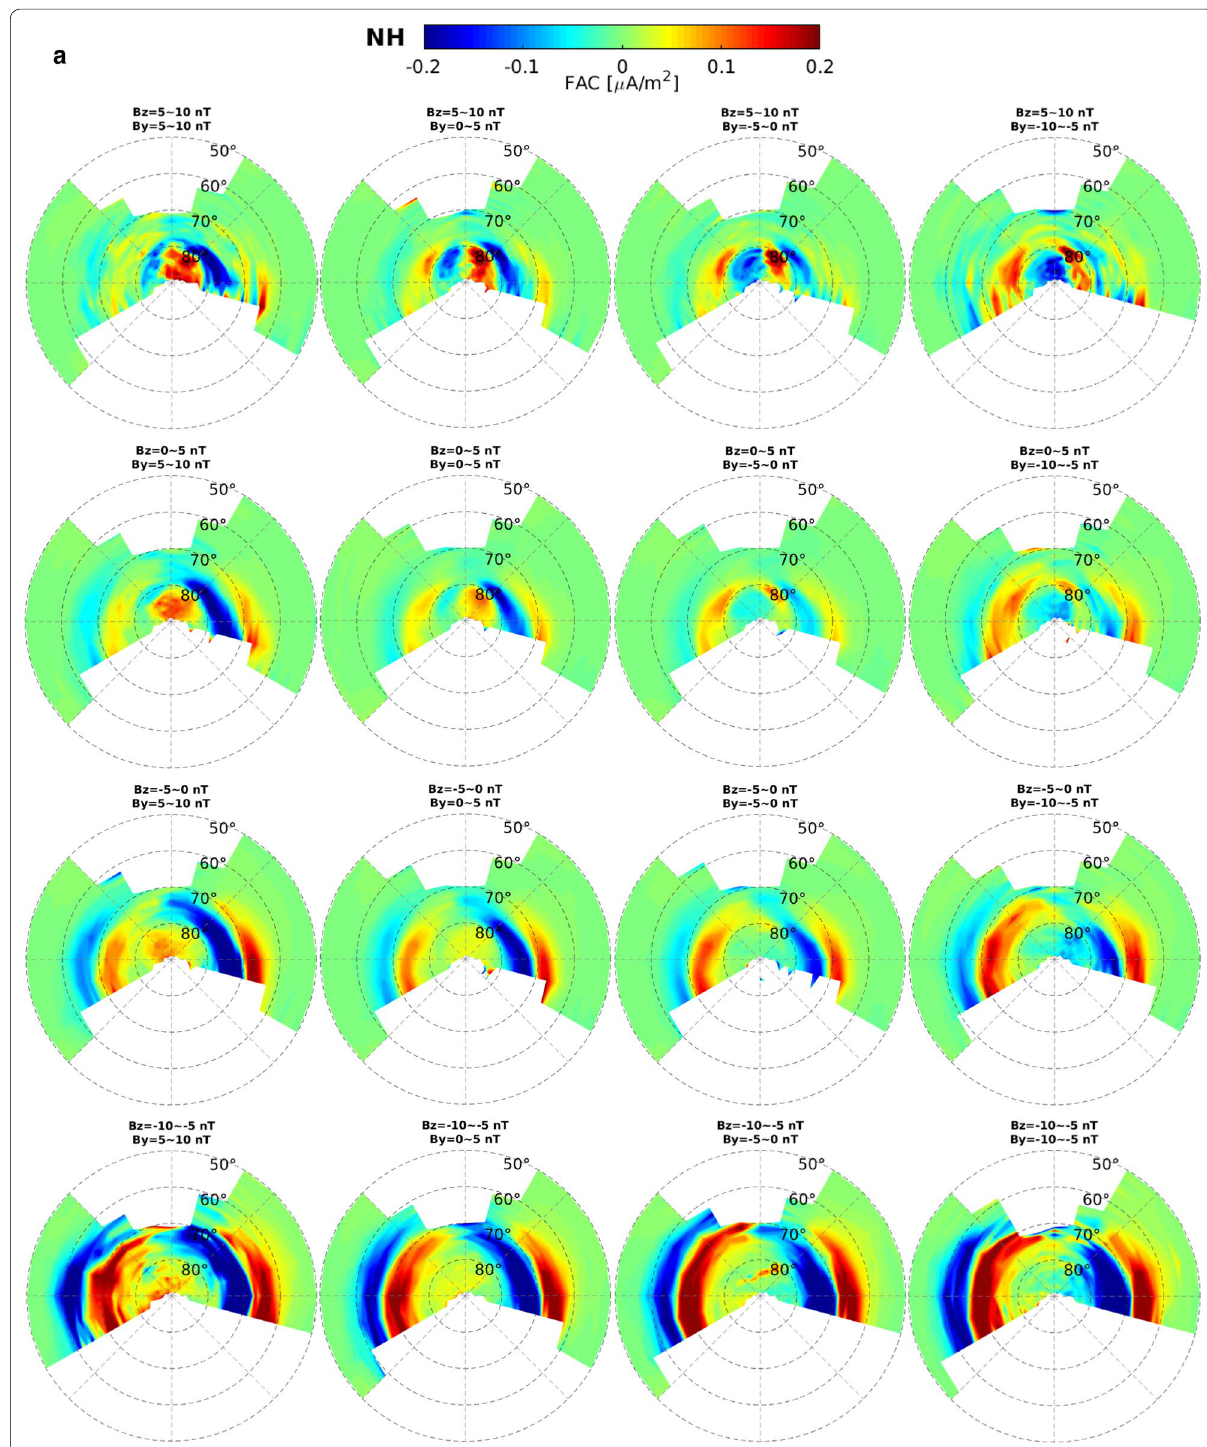
Fig. 4 a. The MLAT versus MLT distribution of FACs derived from the DMSP satellites for the northern hemisphere. The subpanels are arranged by the intensity of IMF B y and B z components: from left to right, the B y component varies from 10 to – 10 nT, and from top to bottom, the B z varies from 10 to – 10 nT, both with a step of 5 nT. b As the same as Fig. 4a, but for the FACs distribution in the southern